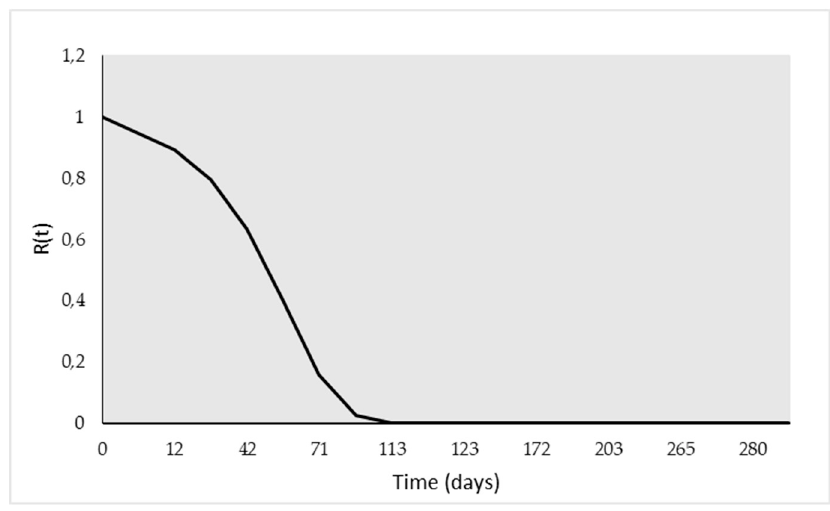
Figure 6. Reliability function.